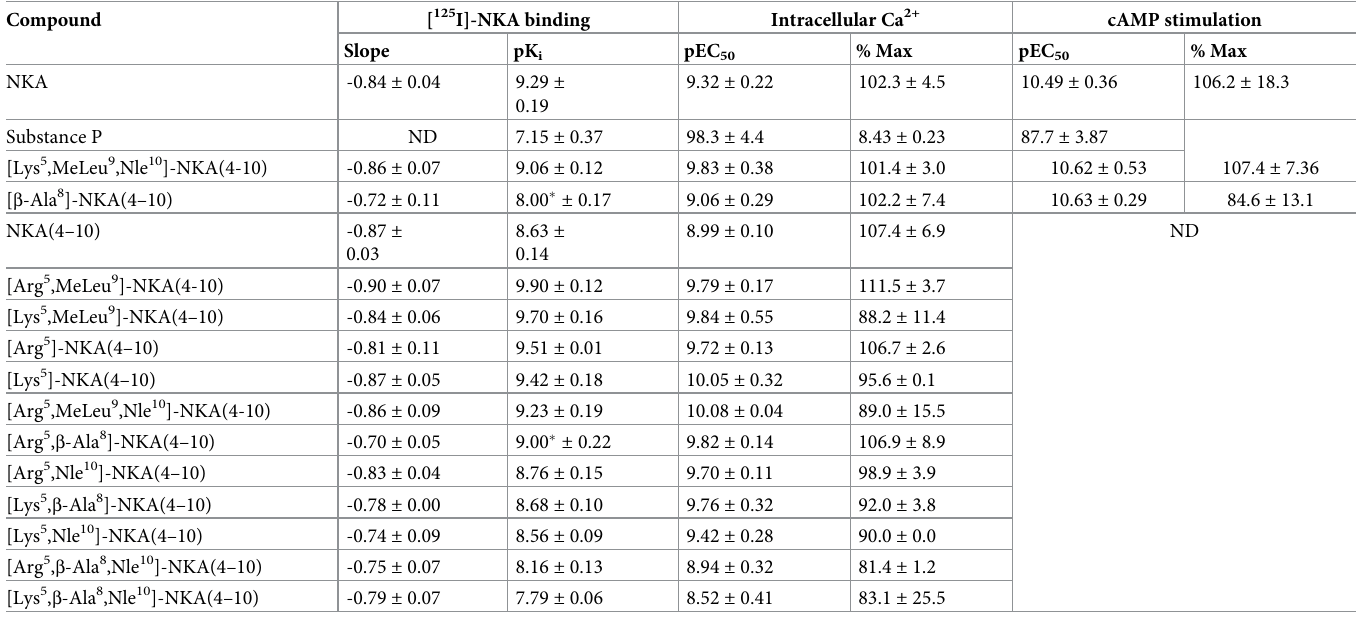
Table 2. Displacement of [ 125 I]-NKA binding, intracellular calcium response and stimulation of cyclic AMP in CHO cells expressing human recombinant NK2 receptors.